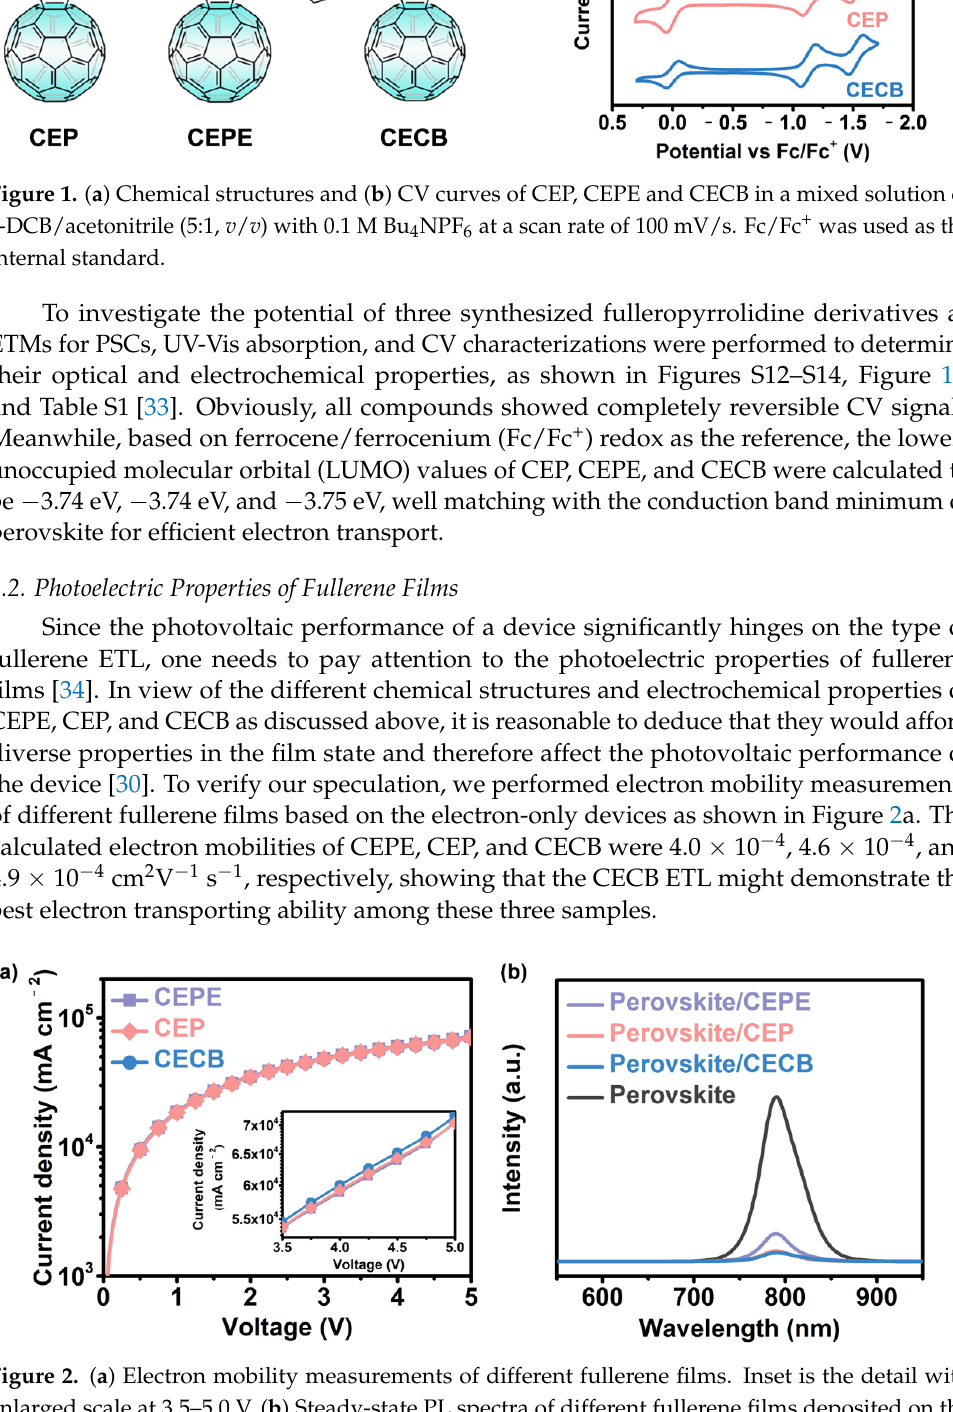
Figure 2. ( a ) Electron mobility measurements of different fullerene films. Inset is the detail with enlarged scale at 3.5–5.0 V. ( b ) Steady-state PL spectra of different fullerene films deposited on the perovskite layers.